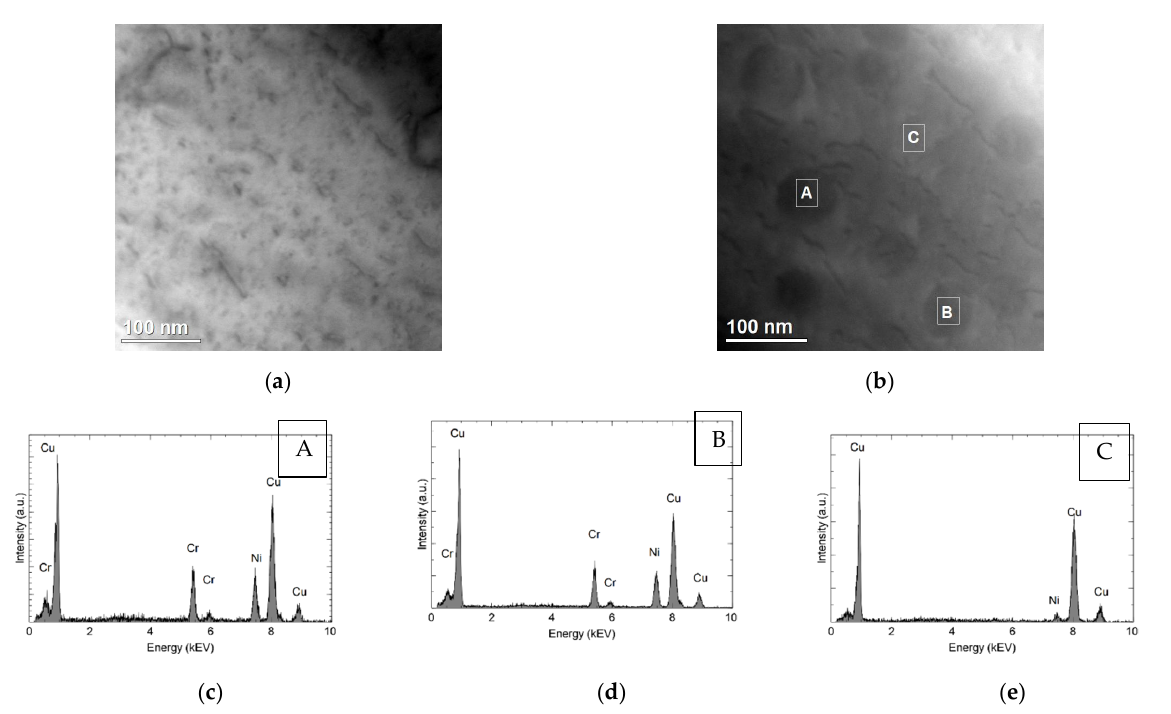
Figure 10. STEM-BF images of coarse Cr precipitates.